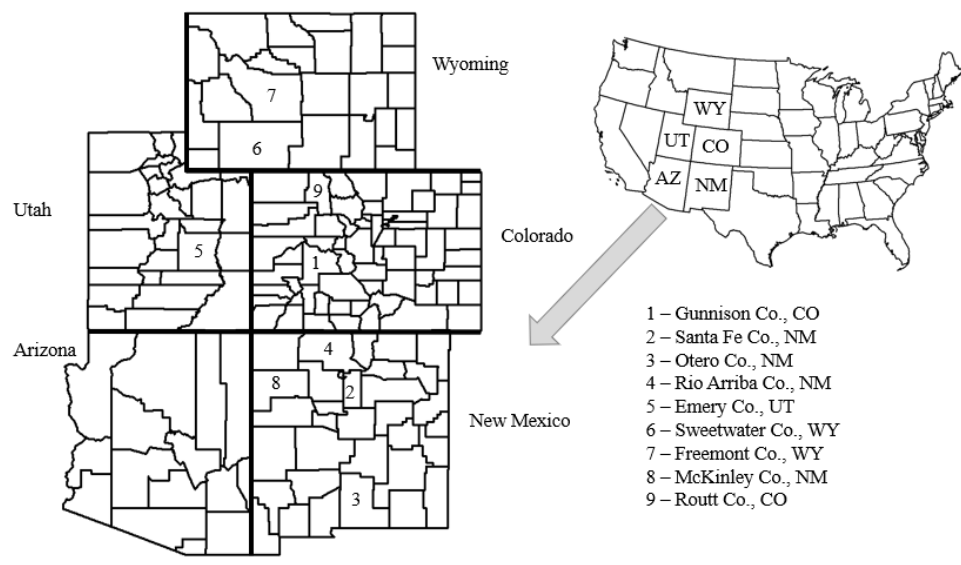
Figure 12. Western USA states with Cretaceous coals mentioned in this section (Alaska is on a separate figure. The counties with coal deposits are numbered on the